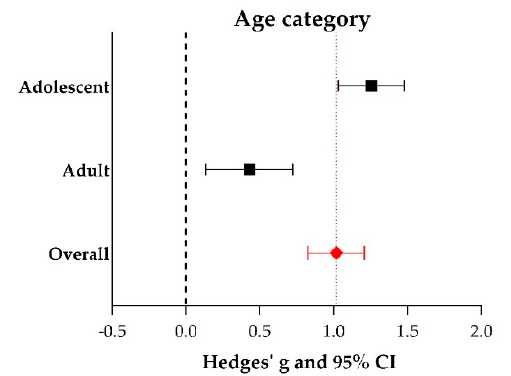
Figure 9. The effect of age on the outcome of vision-based behavioral assays. For every subgroup, Hedges’ g (a measure for effect size using smaller sample sizes, black solid squares) and its 95% confidence interval (CI) are graphically shown. The left side of the dashed black line (Hedges’ g = 0) favors the control group (untreated or sham-operated) and the right side favors the experimental group (RPE transplantation). Overall, RPE transplantation increased vision-based behavior (Hedges’ g 1.018 (0.826–1.209), red diamond). Significant better results were obtained when adolescent animals were used over adult animals (adjusted p-value 0.000033).